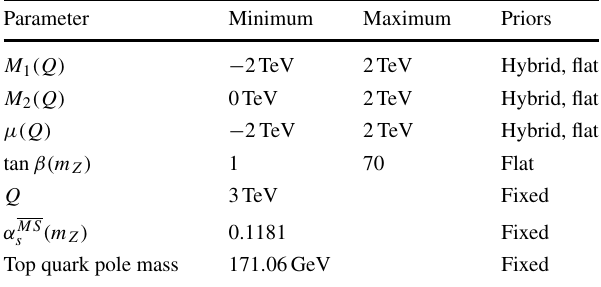
Table 1 Parameters, ranges and priors adopted in the scans of this paper. The “hybrid” prior is flat where | x | < 10GeV, and logarithmic elsewhere. All other soft SUSY-breaking parameters are decoupled; see the text for